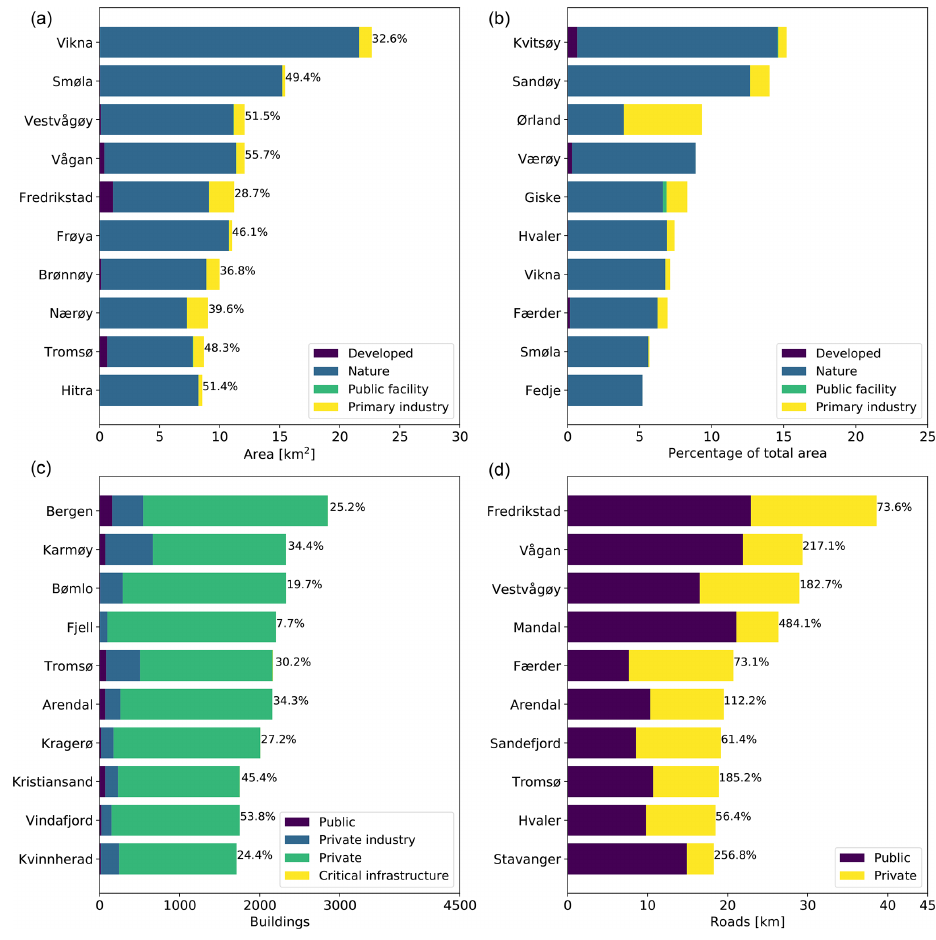
Figure 13. Similar to Fig. 12 but for 2090. The percentages indicate the total change from now to 2090 due to sea level rise.